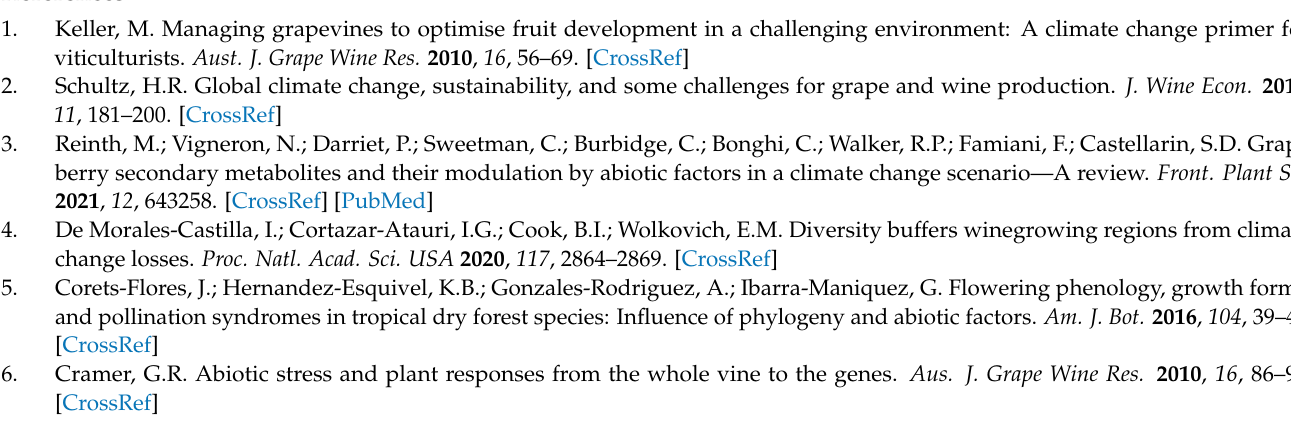
correlations between photosynthetic parameters for Gelu variety in the second year, Table S6. Pearson correlations between photosynthetic parameters for Moldova variety in the second year, Table S7. Pearson correlations between photosynthetic parameters for Purpuriu variety in the second year, Table S8. Pearson correlations between photosynthetic parameters for Coarna neagra variety in the second